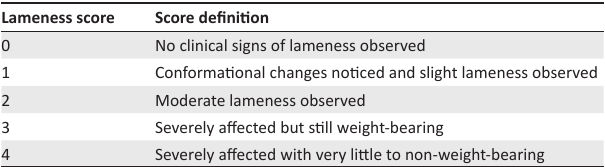
FIGURE 1: Visual lesion evaluation form. TABLE 2: Grading score for lameness. Lameness